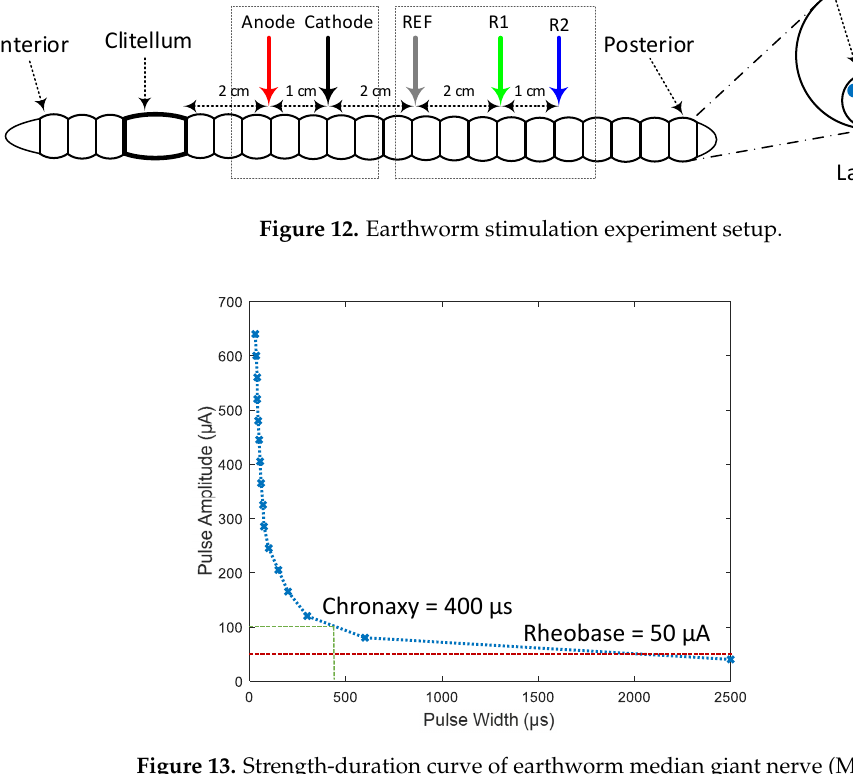
Figure 13. Strength-duration curve of earthworm median giant nerve